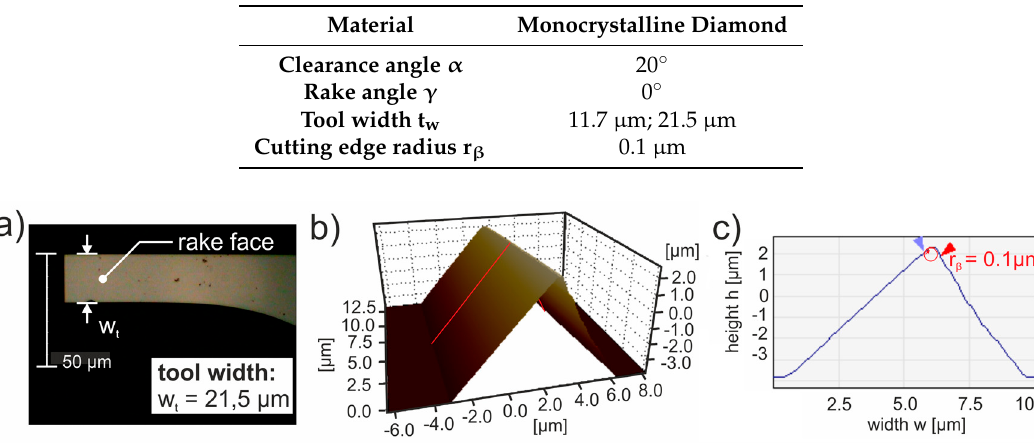
Figure 2. Nanotech 350 FG ultra precision turning lathe and experimental setup. Table 1. Tool characteristics.